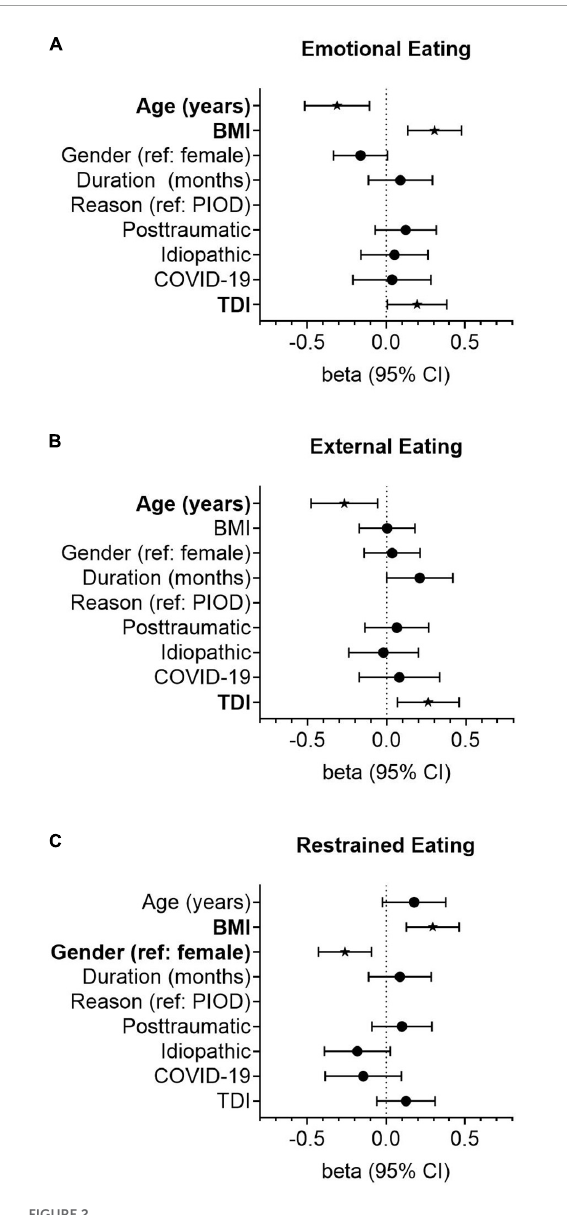
FIGURE2 Forest plots showing the association of smell loss-related variables with the emotional (A) , external (B) , and restrained (C) eating styles. Odds ratios (OR) were calculated using linear regression models adjusted for age (years), gender (reference: female), duration of smell loss (month), the reason for smell loss (reference: postinfectious smell loss), and quantitative olfactory function (TDI). Points represent group-specific OR point estimates, and lines indicate the respective 95% confidence interval (CI).